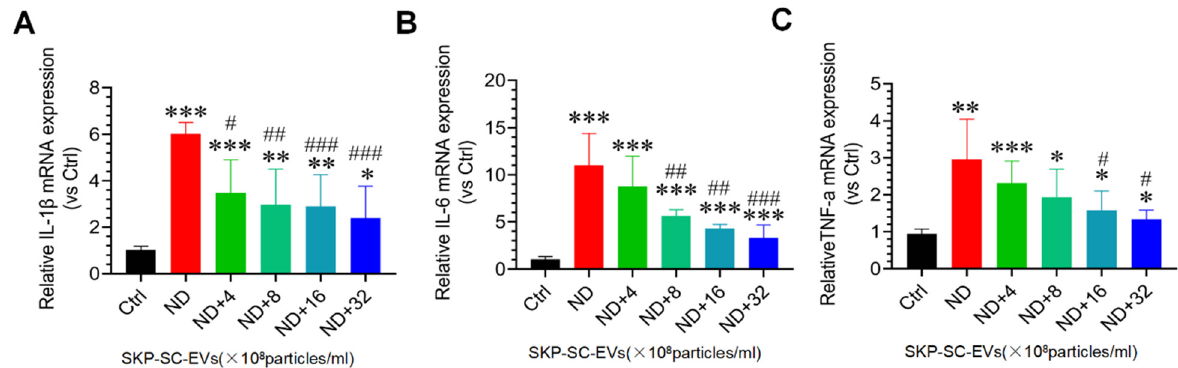
Figure 5. SKP-SC-EVs inhibit inflammation in myotubes after nutrient deprivation. ( A – C ) qRT-PCR analysis of the expression of IL-1 β , IL-6, and TNF- α in myotubes 12 h after treatment with HBSS with or without SKP-SC-EVs (4 × 10 8 , 8 × 10 8 , 16 × 10 8 , and 32 × 10 8 particles/mL). n = 3, * p < 0.05, ** p < 0.01, and *** p < 0.001 vs. Ctrl group; # p < 0.05, ## p < 0.01, and ### p < 0.001 vs. ND group. Ctrl, control; DCF, dichlorofluorescein; EVs, extracellular vesicles; HBSS, Hank’s balanced salt solution; IL, interleukin; ND, nutritional deprivation; SCs, Schwann cells; SKP, skin-derived precursors; TNF- α , tumor necrosis factor- α .